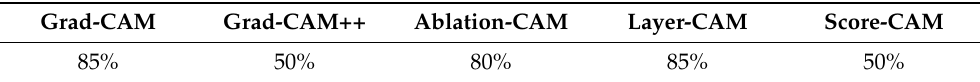
Table 1. Naïve thresholding of attribution maps in activation-based methods. The percentages of muted relevance scores are shown. Grad-CAM Grad-CAM++ Ablation-CAM Layer-CAM Score-CAM 85% 50% 80% 85%